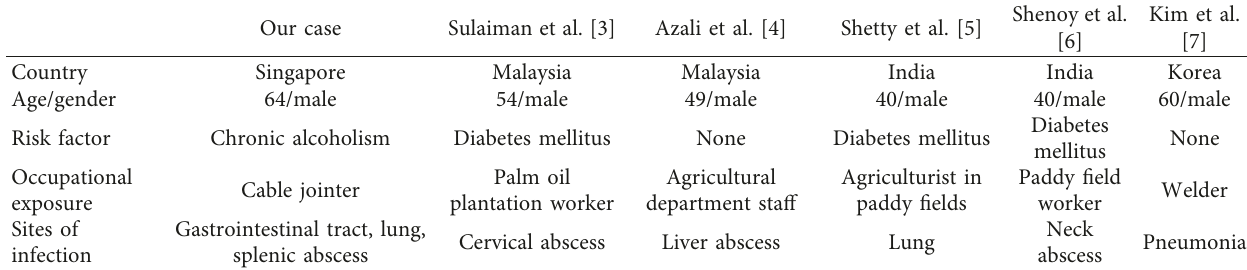
Table 2: Clinical features and demographics of patients with reported melioidosis and tuberculosis